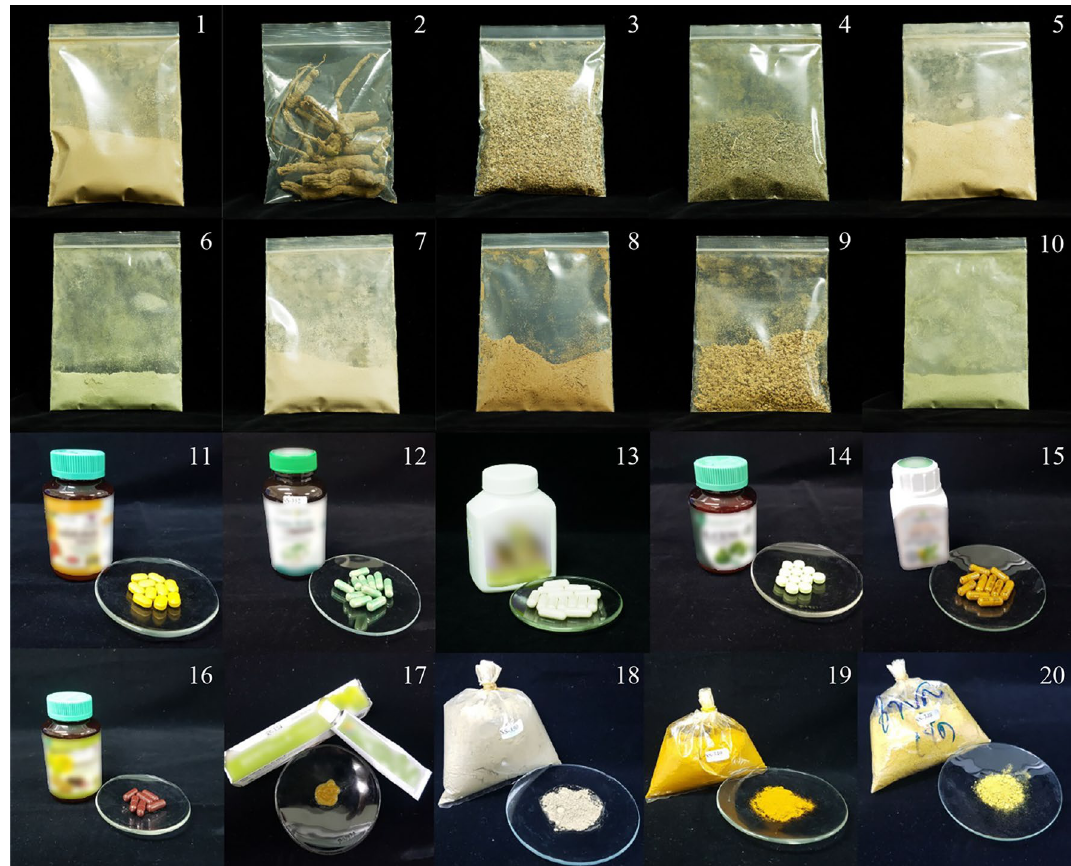
Figure 1. Different dosage forms of herbal products analyzed in this